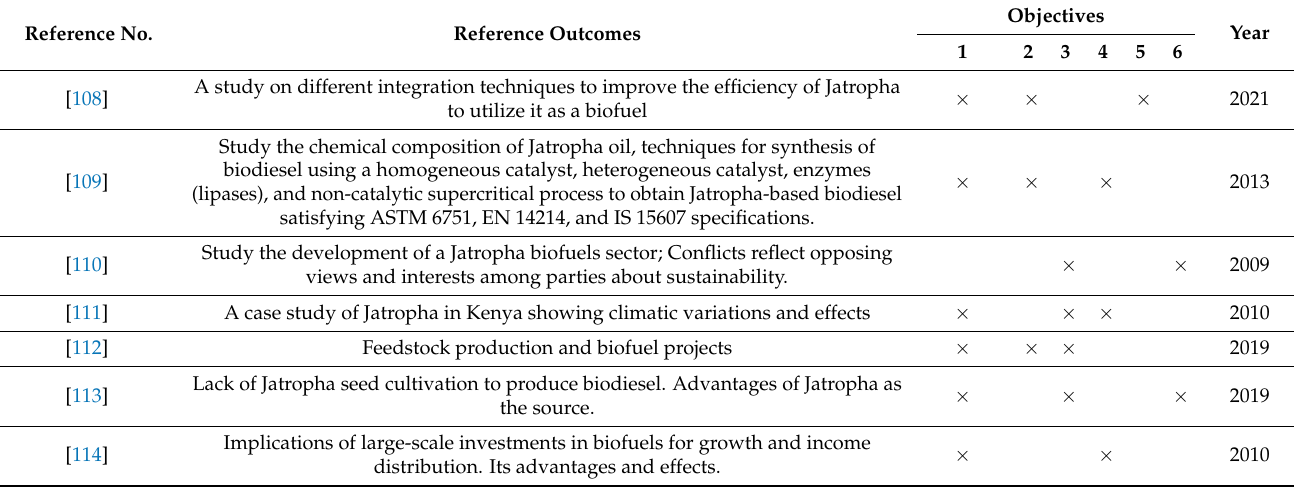
Table 4. List of studies related to Jatropha for utilizing it as a